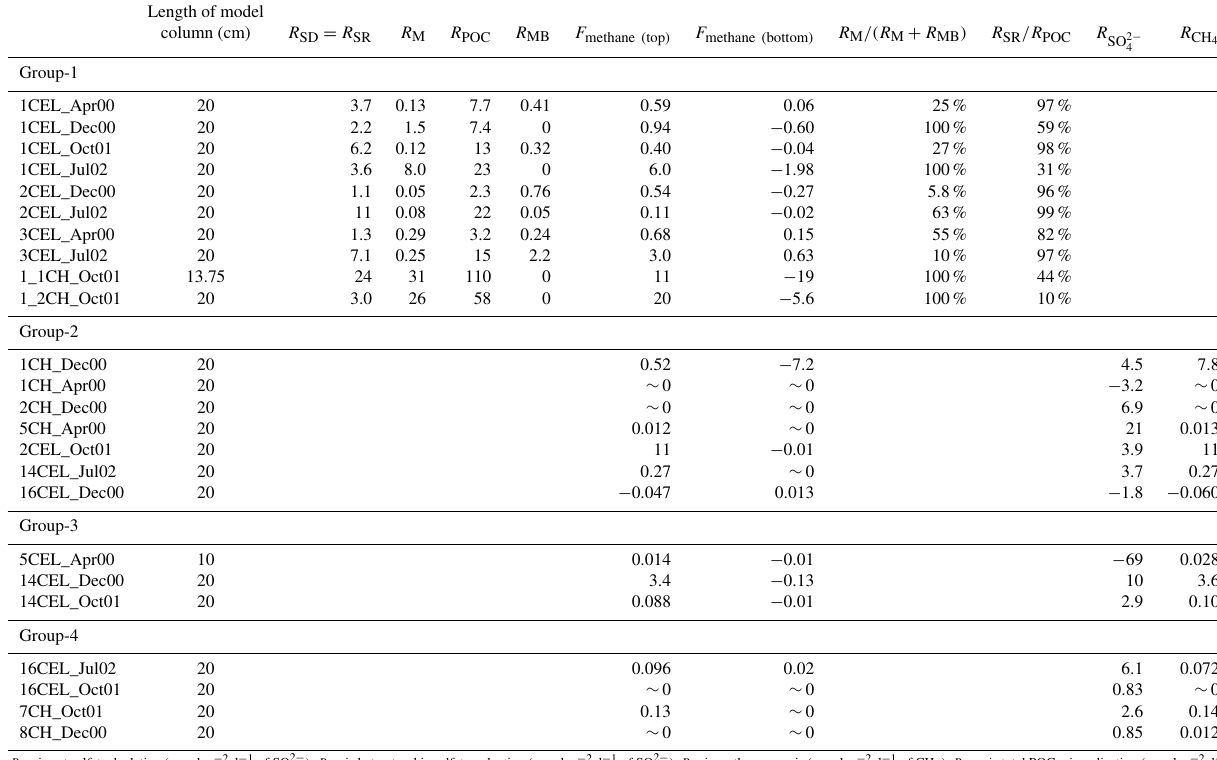
Table 2. Model-derived depth-integrated turnover rates (mmolm − 2 d − 1 ) , dissolved methane fluxes to the water column (mmolm − 2 d − 1 ) and contributions of methanogenesis to net methane production (%) and heterotrophic sulfate reduction to POC degradation (%). CEL and CH represent cores collected from Celestún Lagoon and Chelem